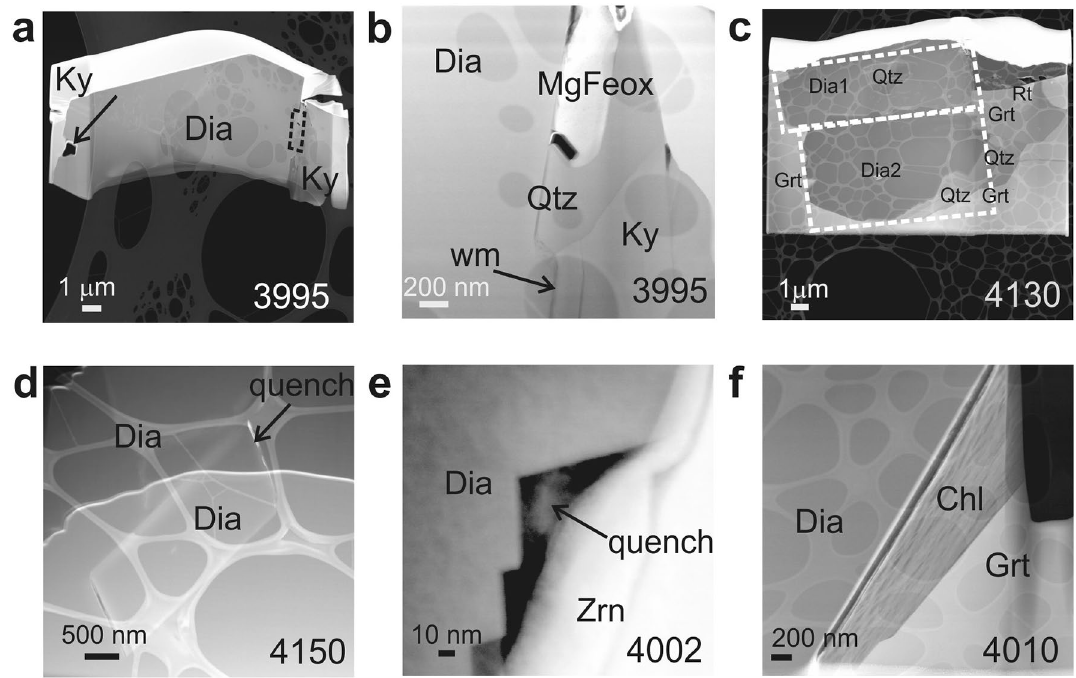
Figure 3. TEM images showing the character of diamond-host interface and internal diamond structure. ( a , b ) Rock A. Octahedral diamond in kyanite with sharp, straight boundaries, with a single void (arrow in a ), and the late assemblage Mg-ferrite-white mica-quartz at diamond-kyanite interface (rectangle in a , blowup in b : checked by EDX and XRD). ( c – f ) Rock B. Polycrystalline internal structure of diamond cuboids in garnet ( c , two large grains marked by dashed white rectangles) with associated quartz and rutile, and in zircon ( d ). Amorphous quench material in interstitial space ( d ) and in the open zig-zag-shaped interface between diamond and zircon ( e ). ( f ) cuboid diamond hosted by garnet, with open boundary towards chlorite (d 002 -spacing approx. 7 Å) at diamond-host interface. Four-digit numbers refer to FIB-TEM sample numbers in Supplementary Table S2. Note the perforated carbon grid the sample rests on, visible in TEM